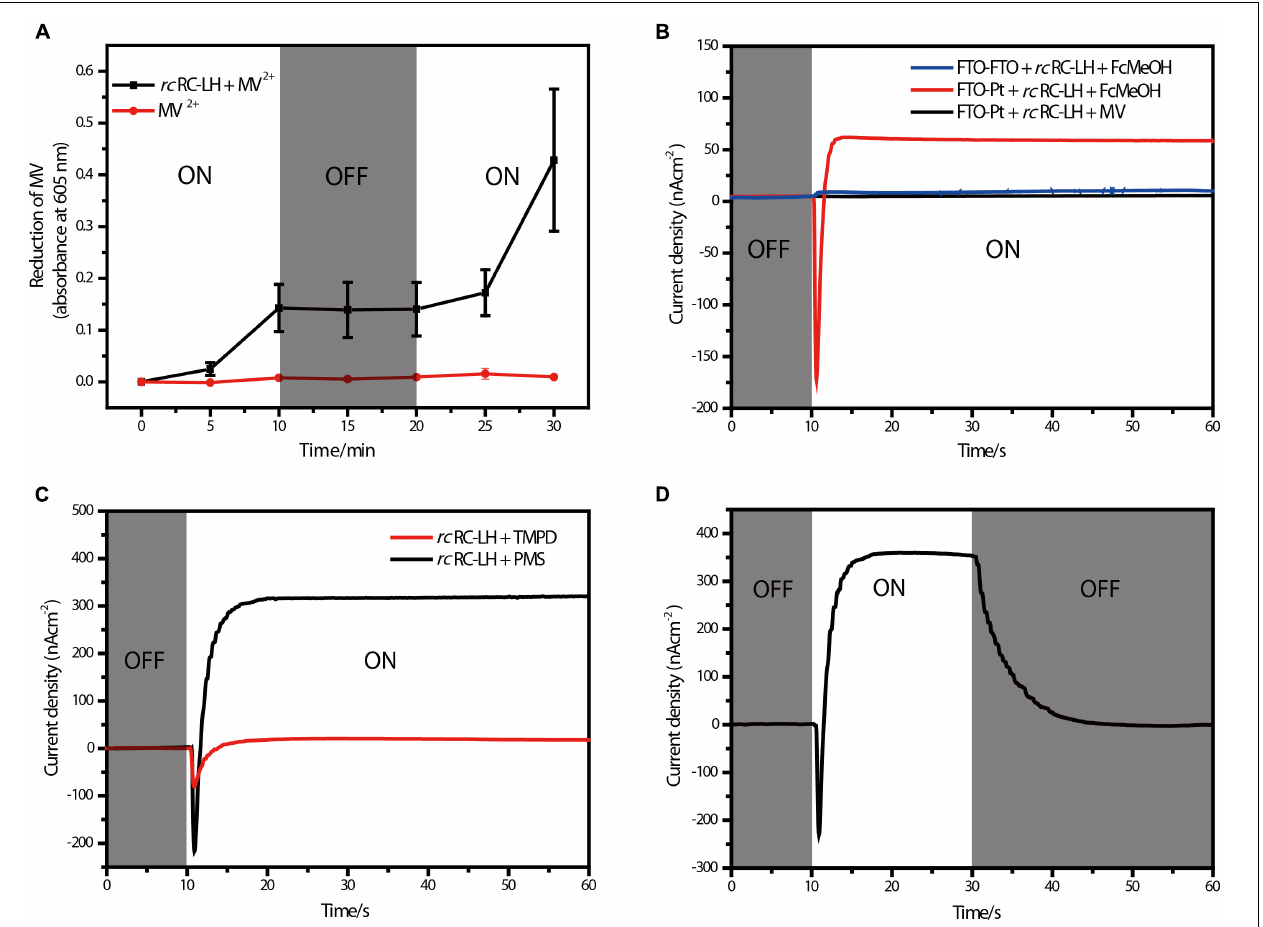
FIGURE 2 | Photoelectric characterizations of the FTO-Pt PBEC. (A) Photoreduction activity of the rc RC-LH complex measured by using MV 2 + as the electron acceptor, the absorbance of MV + at 605 nm was recorded in the presence and absence of the rc RC-LH. The illumination period is indicated in the white sections of graph, and the dark period is indicated in gray. (B) Measurements of the photocurrent intensities of alternative PBECs. The photocurrent intensities were plotted over time with (white background) or without (gray background) illumination. One PBEC was prepared using FTO-glass as both electrodes (FTO-FTO), the other PBEC was prepared with only FTO-glass as the front electrode (FTO-Pt). FcMeOH (hydroxymethylferrocene) and MV (methylviologen) were used as the mediators in these PBECs. (C) Comparison of the photocurrent intensities of the FTO-Pt PBECs prepared using TMPD and PMS as the mediators. White graph background indicates a period of illumination, gray represents the period of darkness. (D) Changes of the photocurrent intensities of the PMS FTO-Pt PBEC upon alternating illumination conditions. White graph background indicates a period of illumination, gray represents the period of